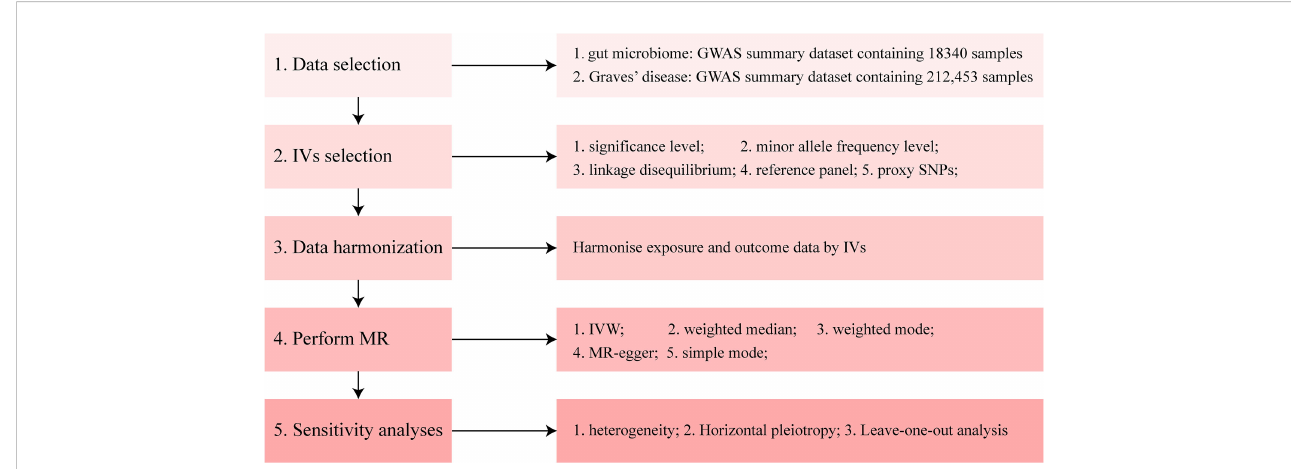
FIGURE 2 Diagram of Mendelian randomization (MR) analysis processing. There were fi ve main parts of the MR analysis in this study. The work fl ow was performed twice for when the exposure was gut microbiome and Graves ’ disease (GD), respectively. The left boxes indicate the name of the parts, and the right boxes contain the speci fi c content of each part. GWAS, genome-wide association study; IV, instrumental variable; IVW, inverse-variance weighting; MR, Mendelian randomization; SNP, single nucleotide